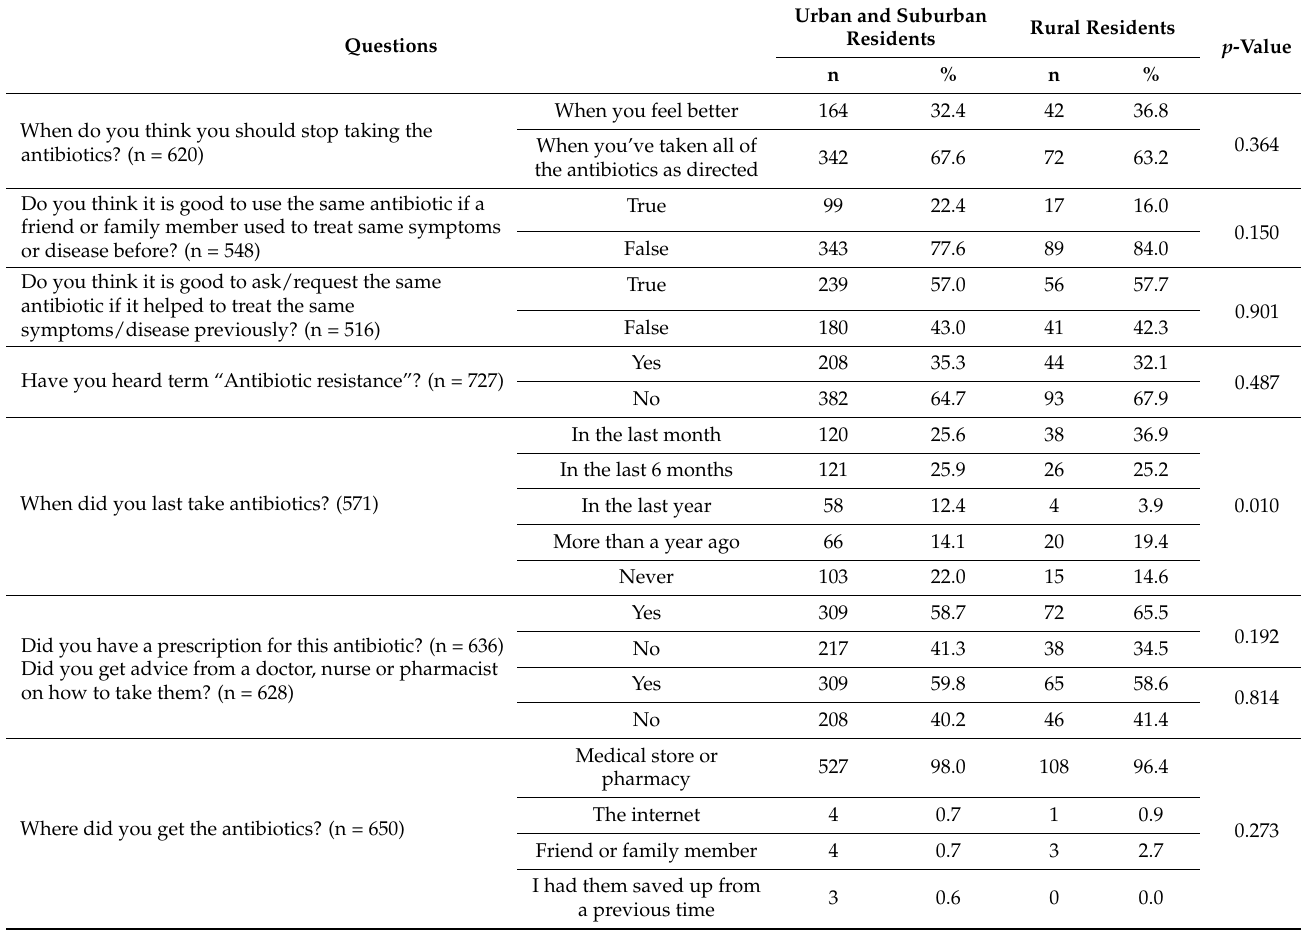
Table 5. Awareness about antibiotic use and resistance by the place of